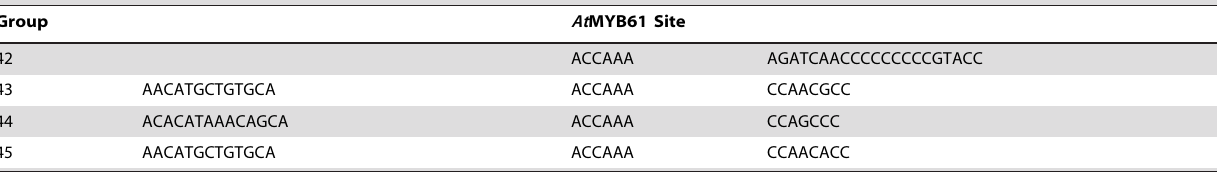
MEME (Multiple EM for Motif Elicitation) identified 7 over-represented hexamer motifs.